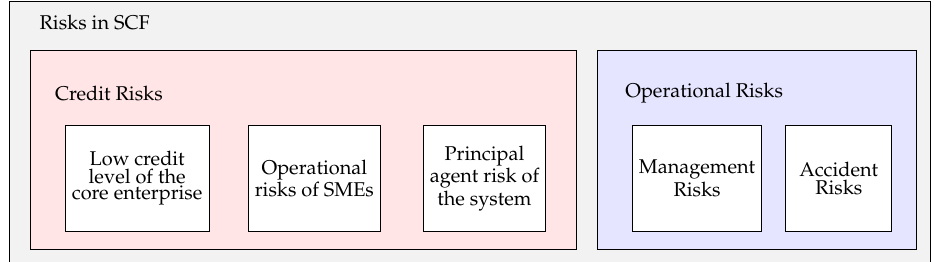
Figure 2. Risks in factoring business of accounts receivable in